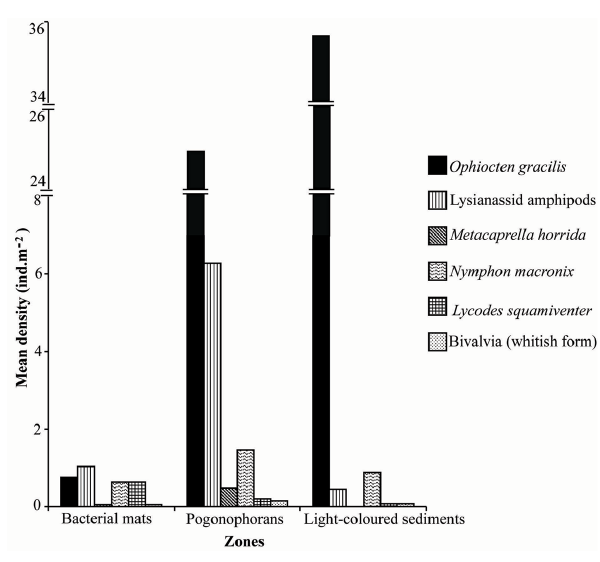
Fig. 9. Mean densities (ind.m − 2 ) of selected taxa in different zones of the H˚akon Mosby mud volcano. Data of three OFOS transects (I, II and III)